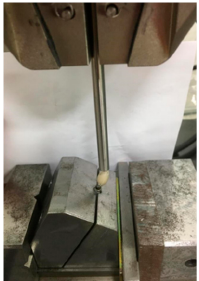
Figure 3. Thirty-degree loading of the assembled specimen with an all-electric dynamic test instrument.